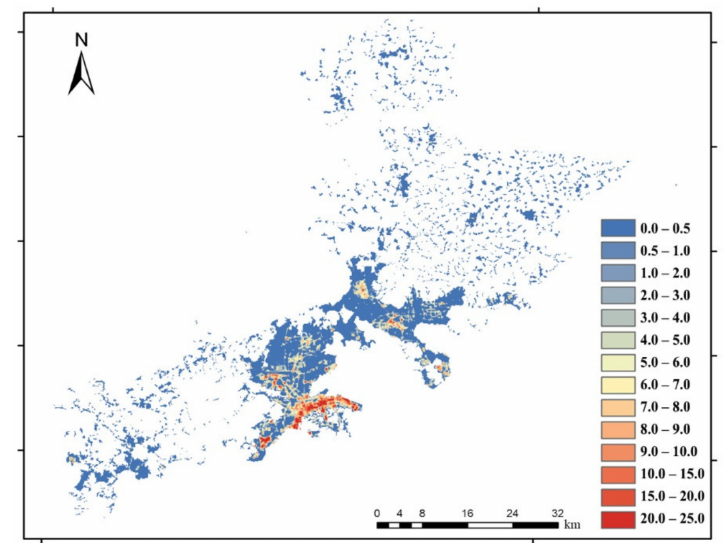
Figure 20. Inversion data of urban regional illumination in Dalian City. Using the illuminance data of the study area, FOS questionnaire data, and environmental information data as data sources, the horizontal illuminance thresholds corresponding to different FOS levels were calculated by regression analysis. We use the illuminance thresholds corresponding to different FOS levels and the data classification tool of GIS to reclassify the ground horizontal illuminance inversion data and draw the night lighting safety map of Dalian (Figure 21). The ground horizontal illuminance inversion data are divided into four categories: the area with FOS < 1 is very unsafe, the area with 1 ≤ FOS < 2 is slightly unsafe, the area with 2 ≤ FOS < 3 is relatively safe, and the area with 3 ≤ FOS is very safe.